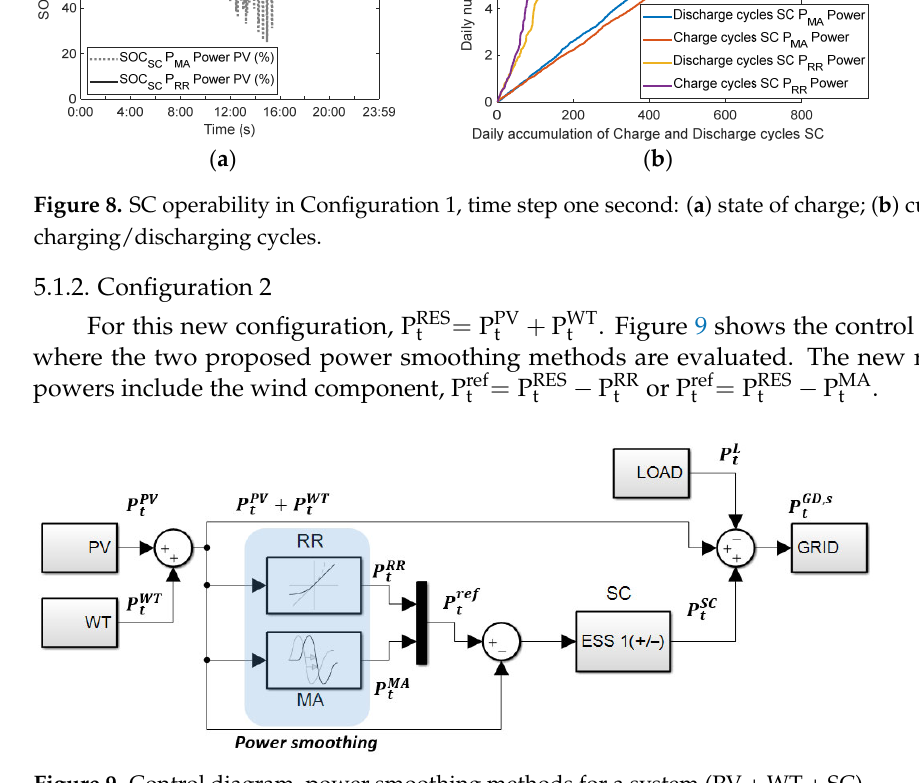
Figure 9. Control diagram, power smoothing methods for a system (PV + WT + SC).